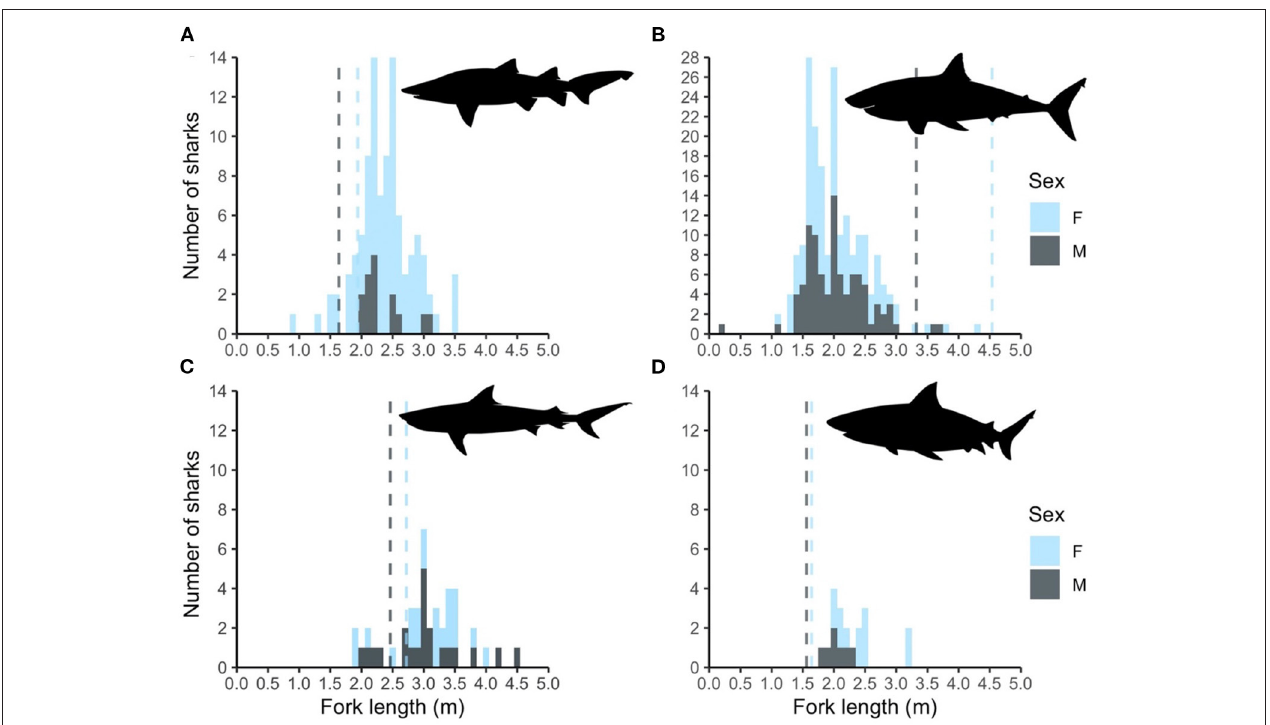
FIGURE 2 | Histogram of fork length distribution of the (A) grey nurse, (B) white, (C) tiger, and (D) bull sharks caught in the Shark Meshing Program between 1998 and 2019 by sex. Dashed lines represent sex-specific maturation sizes for each of the species obtained from the